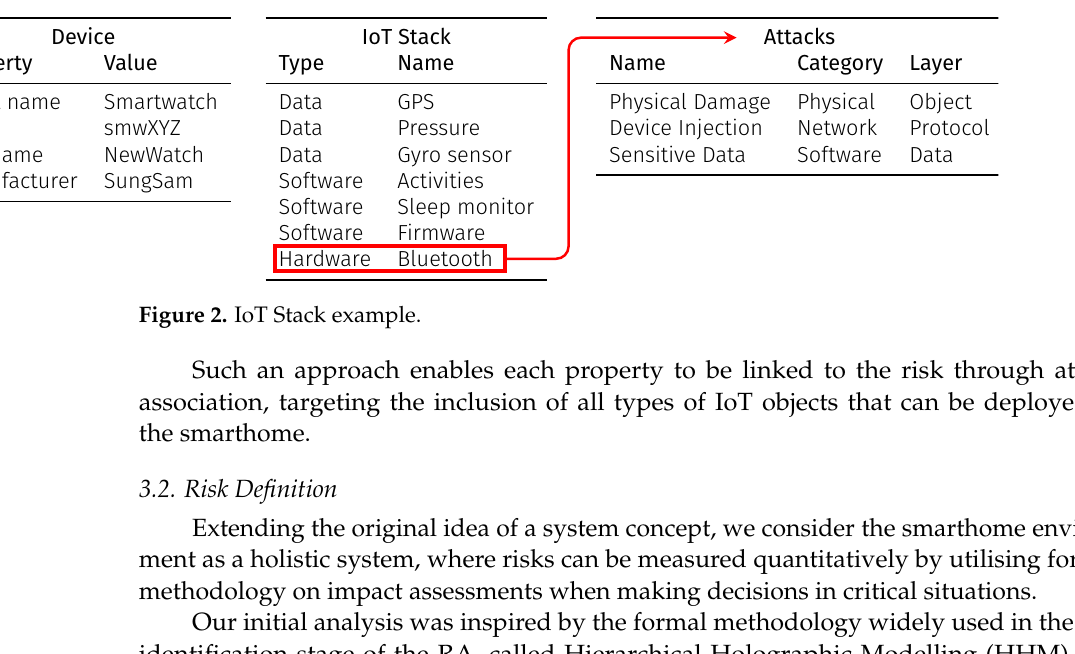
Figure 1. IoT Stack with many-to-many relationship concept.